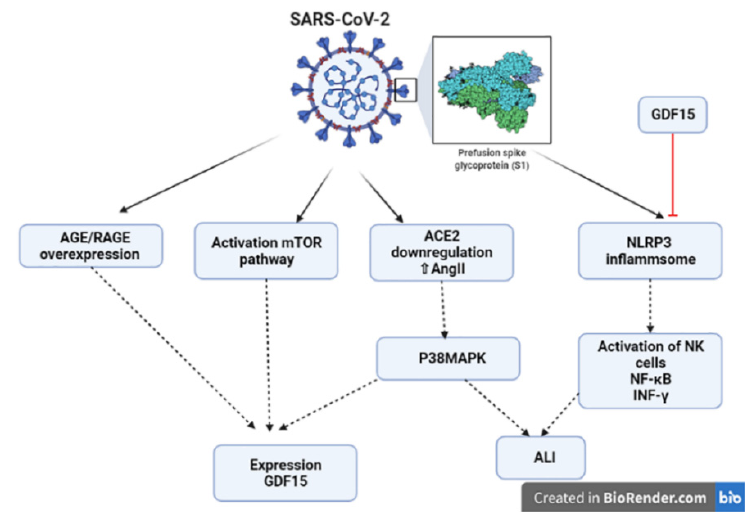
Figure 2. Growth differentiation factor 15 (GDF 15) and its pro-inflammatory and anti-inflammatory signaling in COVID-19. mTOR (rapamycin) pathway, ACE2 (angiotensin-converting enzyme 2), AngII (angiotensin II), p38 mitogen-activated protein kinase (p38MAPK), ALI (acute lung injury), NK cells (natural killer cells), nuclear factor kappa B (NF- κ B) and interferon-gamma (INF- γ ).